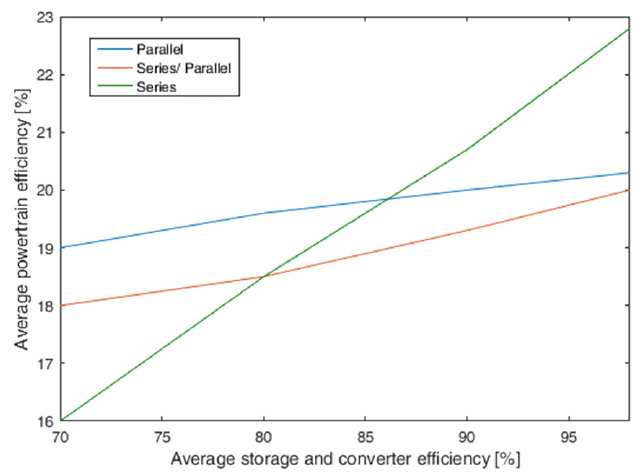
Figure 33. Relation between architecture efficiency and electric component efficiency for different architectures (Parallel, Series/Parallel, and Series).